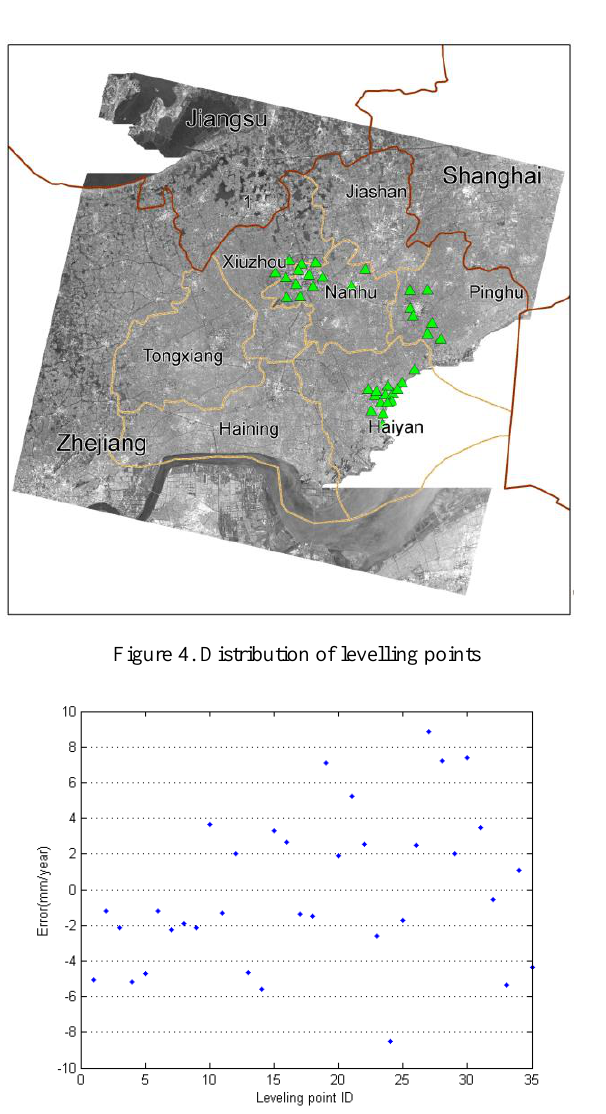
Figure 5. The errors between levelling measurements and InSAR